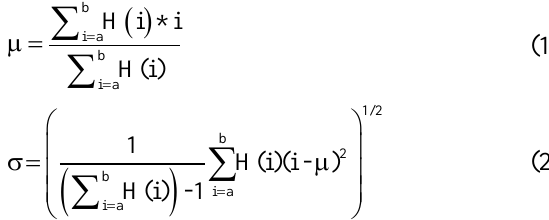
The algorithm of histogram division is: Algorithm 1: Suppose that the brightness level value of image is in